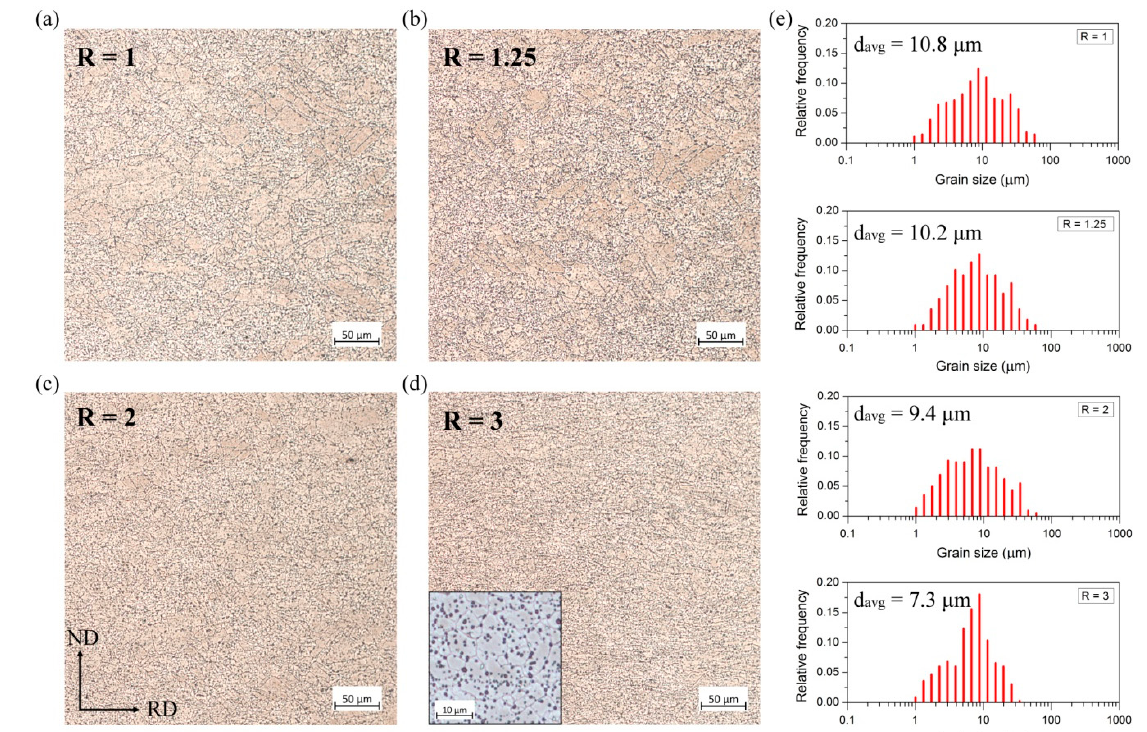
Figure 3. Light microscope (LM) images of the microstructure of the annealed Mg-6Sn sheets processed at speed ratio of ( a ) R = 1, ( b ) R = 1.25, ( c ) R = 2 and ( d ) R = 3 with ( e ) grain size distributions.